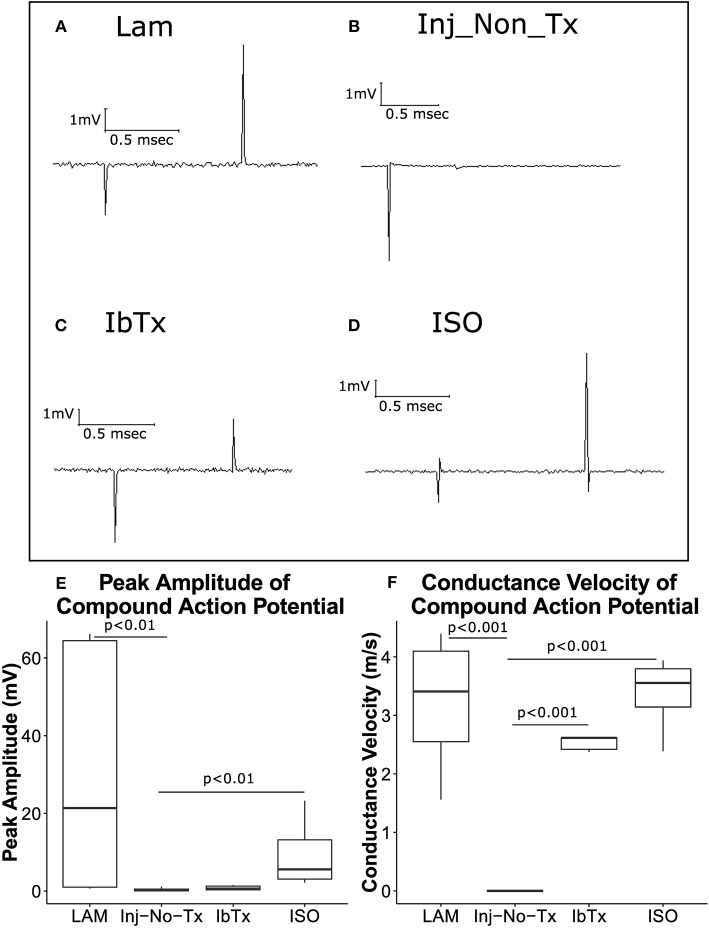
ISO-treated animals exhibit greater axonal survival and CAP velocities compared to injured non-treated animals. Eight weeks post-injury, animals were sacrificed, and spinal cords removed for electrophysiological analysis. Representative traces are shown of CAPs after stimulation of spinal cords at 1 mA for 0.1 ms. (A) LAM (laminectomy only); (B) injured non-treated (Inj-No-Tx); (C) IbTx treated; (D) ISO treated. The arrows indicate the artifact upon stimulation of the spinal cord followed by the CAP. Peak Amplitude of CAPs (E) and conduction velocity (F) were measured. Injured non-treated animals (Inj-No-Tx) exhibited significantly lower peak amplitudes and CAP velocities compared to laminectomised (LAM) animals and animals treated with ISO. Tukey box plots are shown. LAM n = 3; Inj = 4; IbTx = 4; ISO = 6.